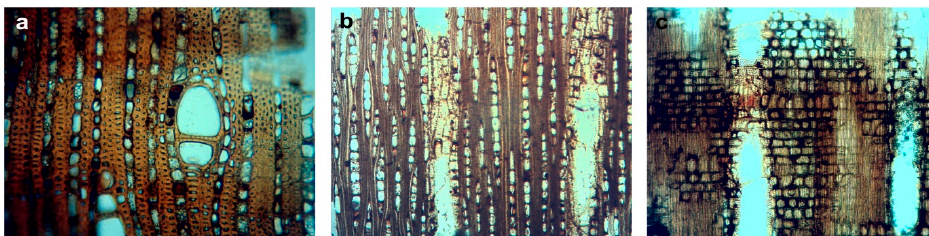
Figure 7. Microphotographs of wood sections under the microscope in transmitted light showing ana-tomical characteristics of Ziziphus spina-christi (L.) Willd. : ( a ) transverse section (TS); ( b ) tangential the anatomical characteristics of Ziziphus spina ‐ christi (L.) Willd. : ( a ) transverse section (TS); ( b ) tan ‐ gential longitudinal section (TLS); ( c ) radial longitudinal section (TLS). longitudinal section (TLS); ( c ) radial longitudinal section